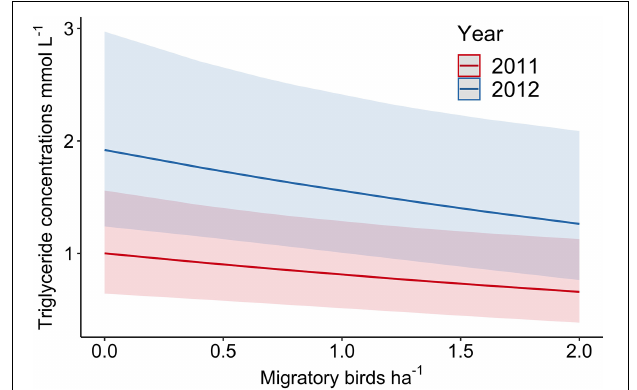
FIGURE 4 | Estimated marginal means ± 95% CI of refueling performance of 101 individuals of 24 species of migrating birds, as measured by triglyceride concentrations, by the same-day density of migrating birds during 2011 and 2012 (random effect with a varying intercept).